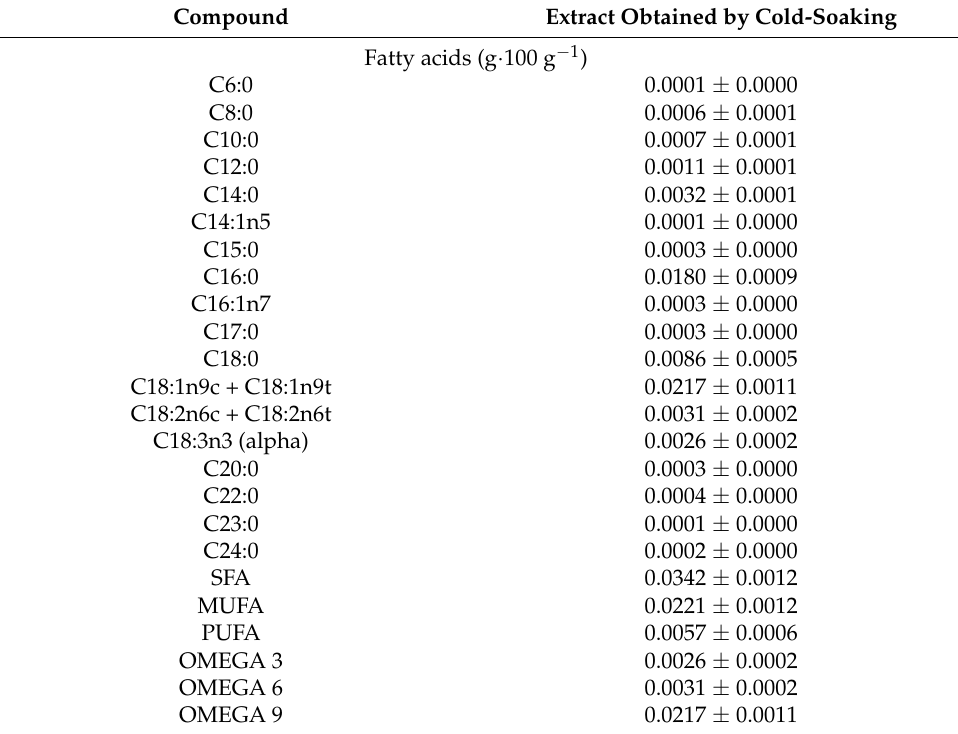
Table 3. Fatty acids in water extracts from L. usitatissimum (average ± SD).